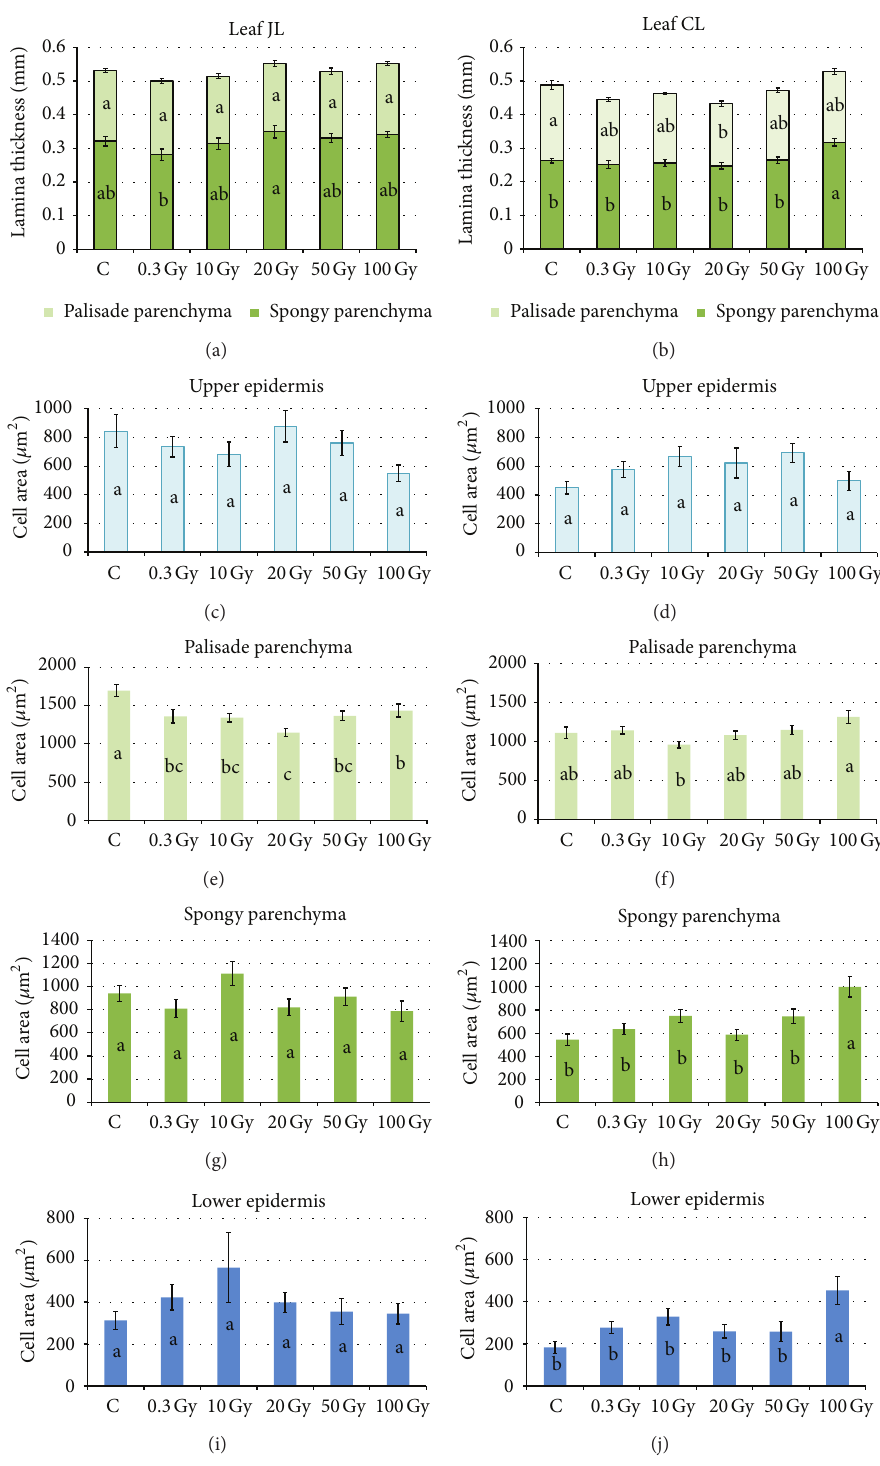
Figure 5: Lamina thickness (a, b) and cell area of upper epidermis (c, d), palisade (e, f), spongy (g, h) parenchymas, and lower epidermis (i, j) of S. lycopersicum L. “Microtom” leaves of control and irradiated plants at different doses of X-rays in both juvenile (JL) and compound (CL) leaves. Mean values and standard errors are shown ( 𝑛 = 15 in (a, b); 𝑛 = 45 in (c–j)). Different letters correspond to significantly different values according to multiple comparison tests ( 𝑃 < 0.05